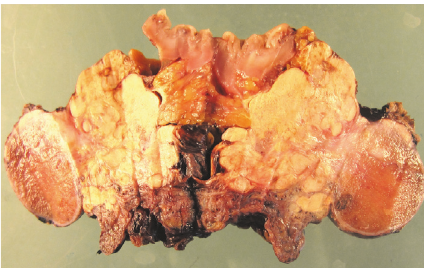
Figure 6: Gross photograph of retroperitoneal mass. A 4.3 cm lob- ulated solid white-yellowish mass with fibrous bands and extensive necrosis is seen adjacent to the undescended testis and a segment of